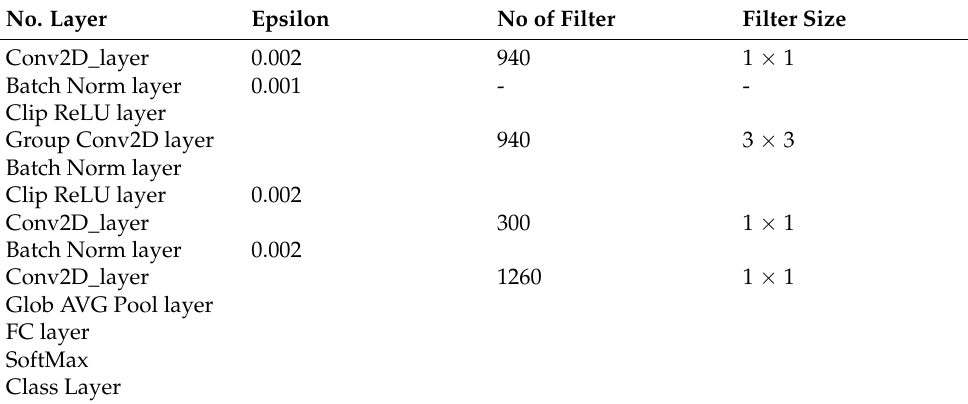
Table 2. Presents the number of parameters of the proposed model in brain tumor